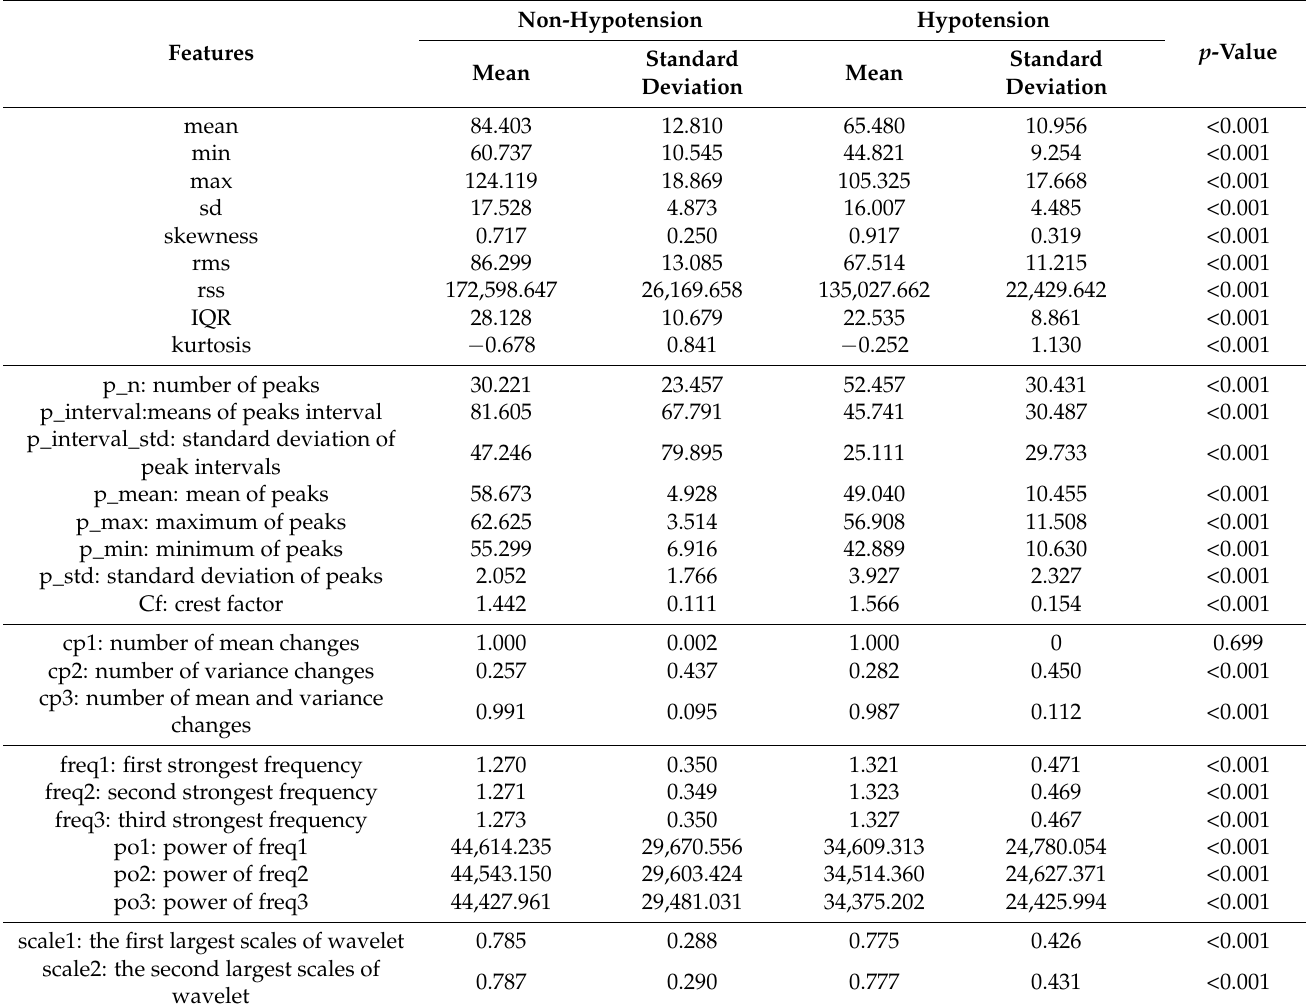
Table 5. Clinical patient characteristics in terms of vital signs.